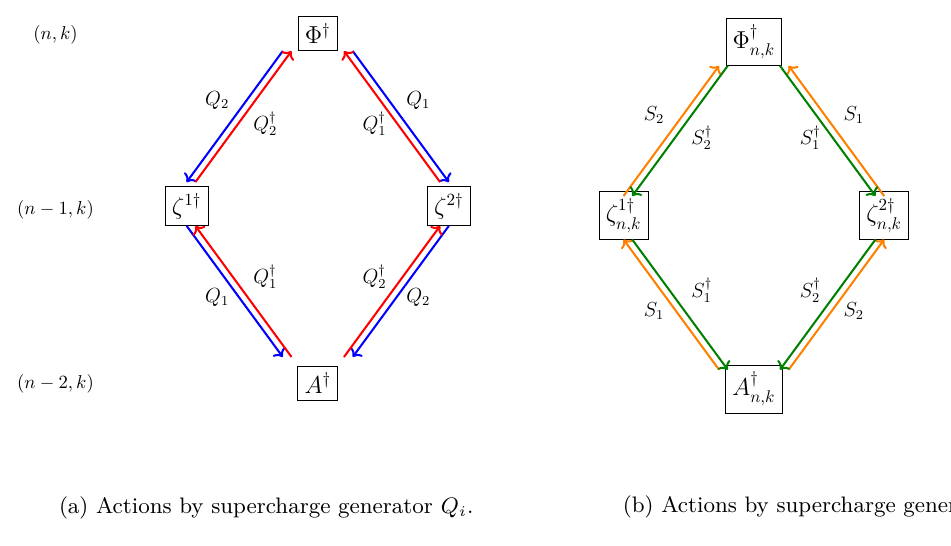
Figure 2. Structures of letters as an N = 2